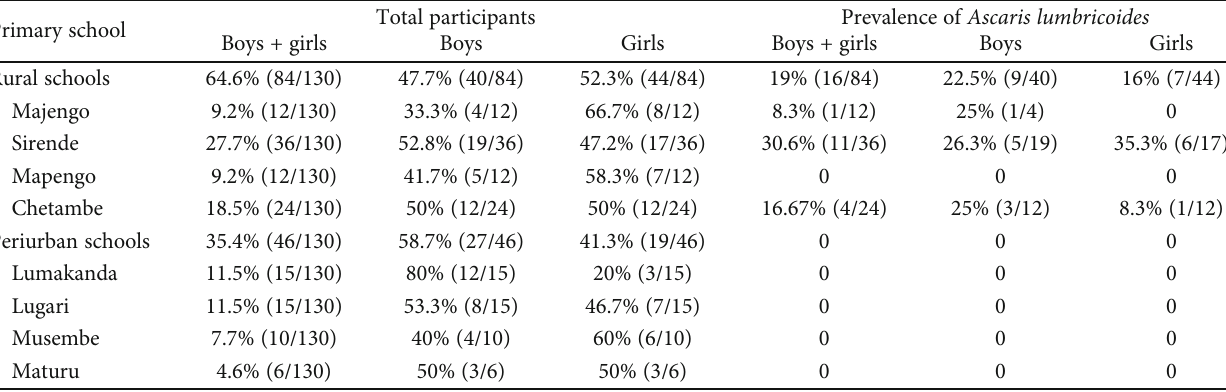
Table 1: Prevalence of Ascaris lumbricoides in preschool pupils.